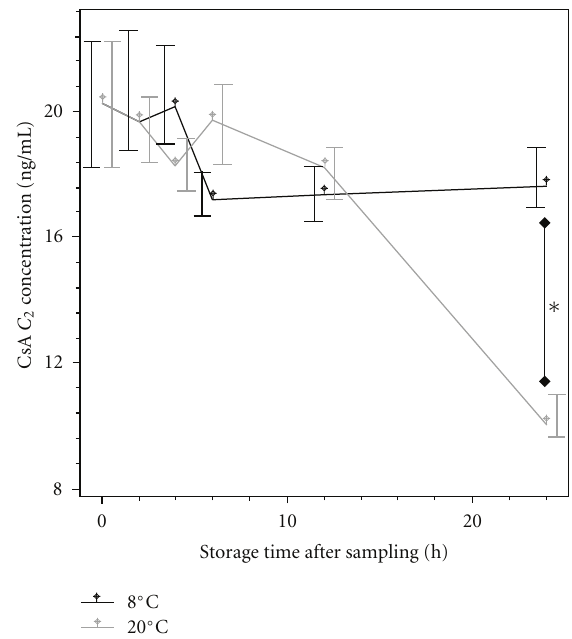
Figure 1: Stability of CsA in dried blood spots at di ff erent ambient temperatures. Medians and 95% coverage intervals of e ff ective CsA C 2 concentrations in dried blood spots stored at 8 ◦ C and 20 ◦ C, ∗ ( P < . 05)